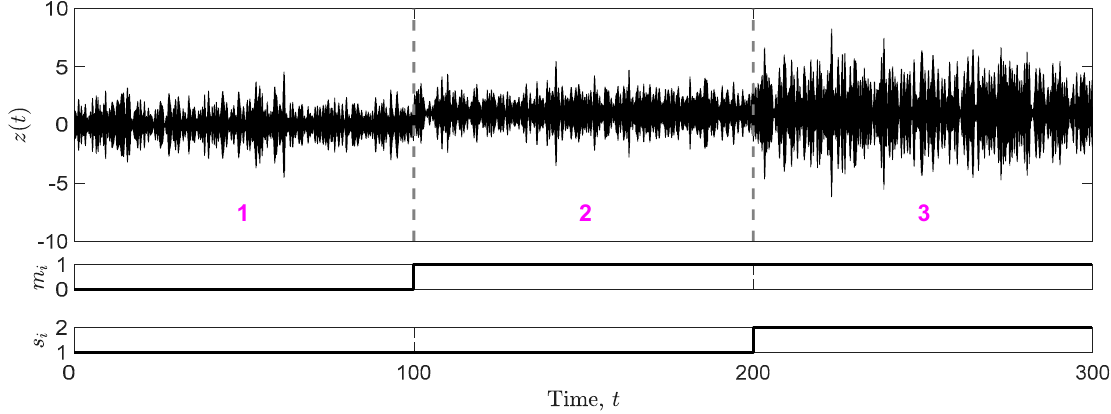
Figure 3. Load A: three states of same duration 𝑇 (cid:3020),(cid:3036) ; the values of 𝑚 (cid:3036) and 𝑠 (cid:3036) are in bottom sub- plots.